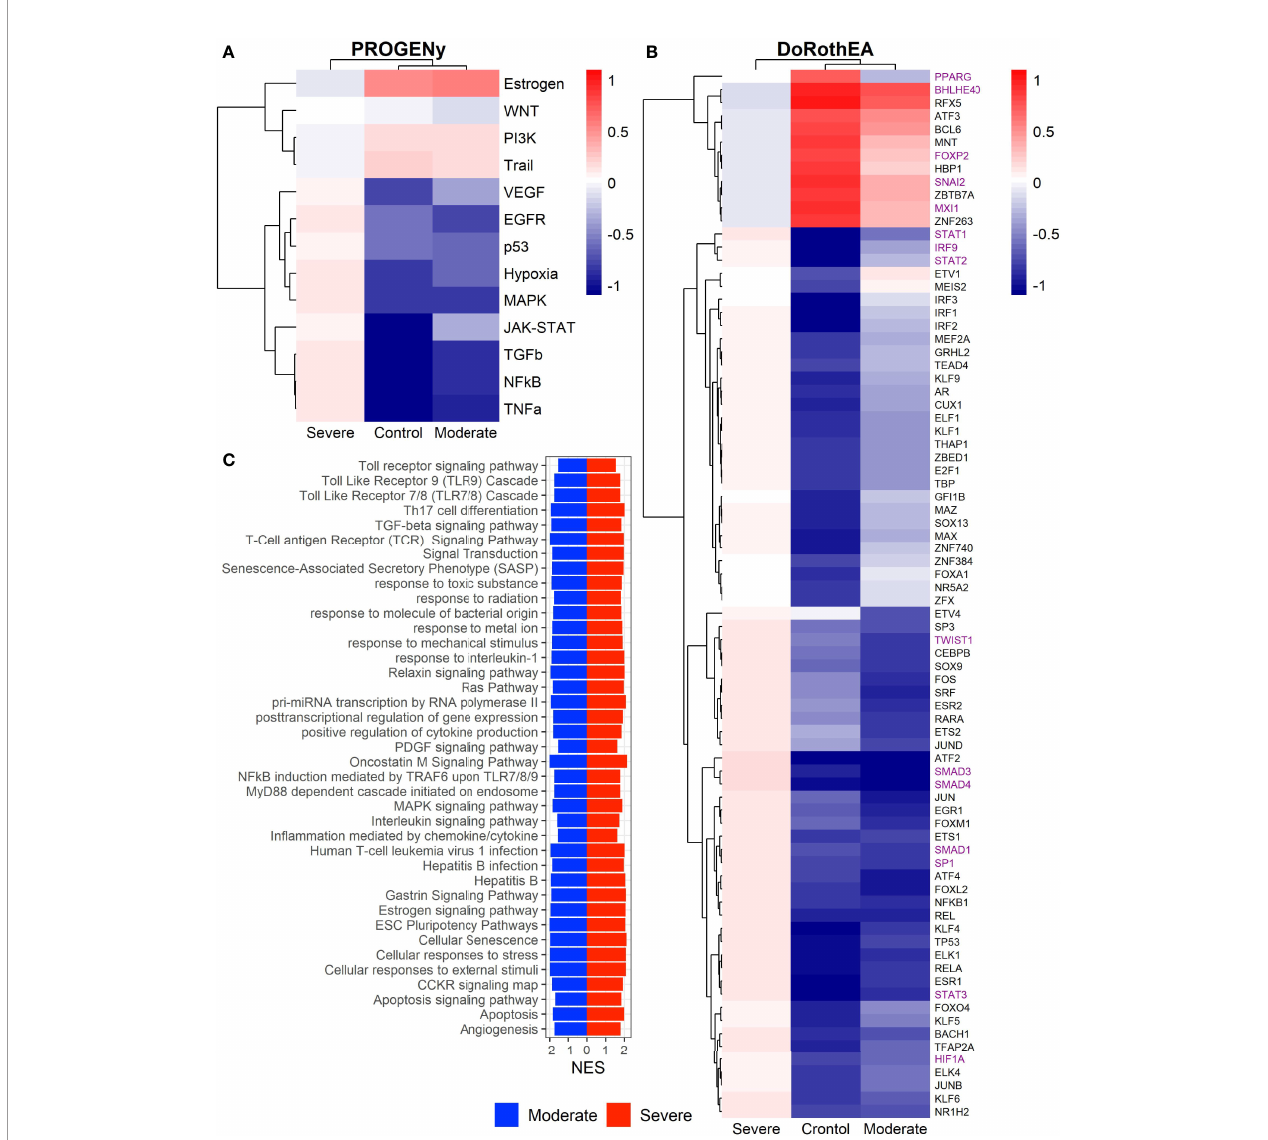
FIGURE 3 | Pathways and transcription factors dysregulated on epithelial cells among patients. (A) Changes in the pathways activation/inactivation identi fi ed by PROGENY analysis. White boxes indicate no change of the pathways in the group of patients respectively. (B) Transcription factors inferred by DoRothEA algorithm. Colorbar is related to activation/inactivation values. (C) Pathway Enrichment Analysis, the normalized enrichment score (NES) value represents the activity status within the disease severity conditions. Blue and red bars relate NES values for the moderate and severe patients,